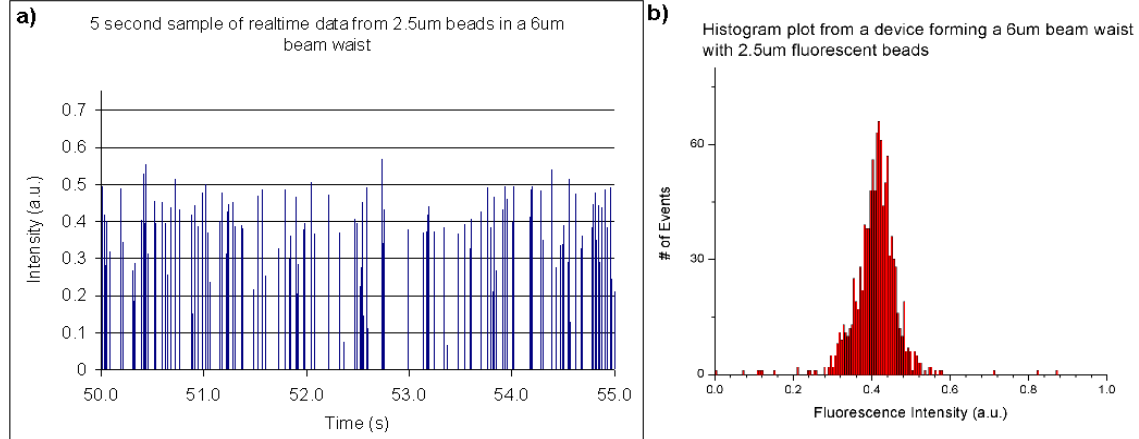
Figure 7. Results of a fluorescence test from 2.5 μ m beads in a device that forms a 6 μ m beam waist. Real-time data ( a ) shows the reliable detection and superior performance as the burst intensities are concentrated around a constant value in the histogram ( b ). The CV of this particular run was 9.03%.